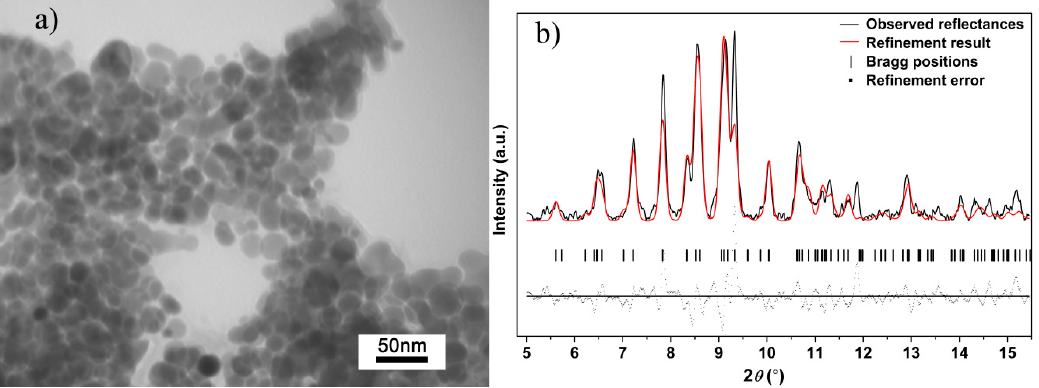
Figure 7. ( a ) TEM images and ( b ) Rietveld refinement result of Ag 2 S nanosheets quenched to ambient conditions; Rwp = 0.3982, Rp = 0.2929 and chi^2 = 160.3.